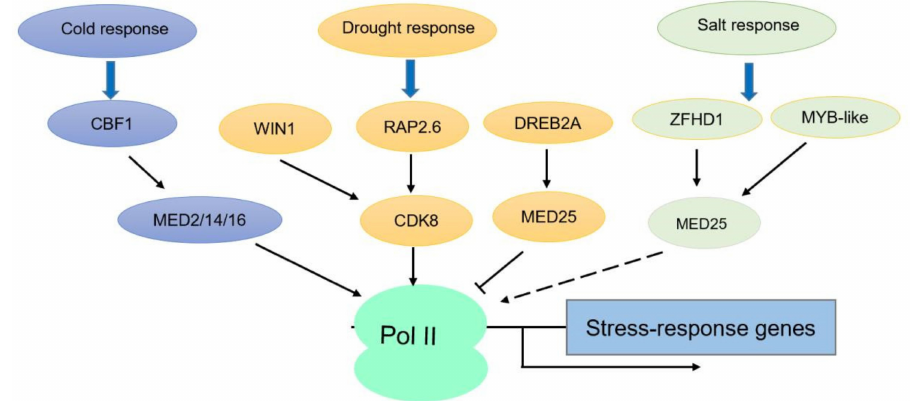
Figure 2. The simplified network of TFs and Mediator complex in regulating the abiotic stress responses. In response to cold stress, CBF1 activates the expression of COR genes through MED2,